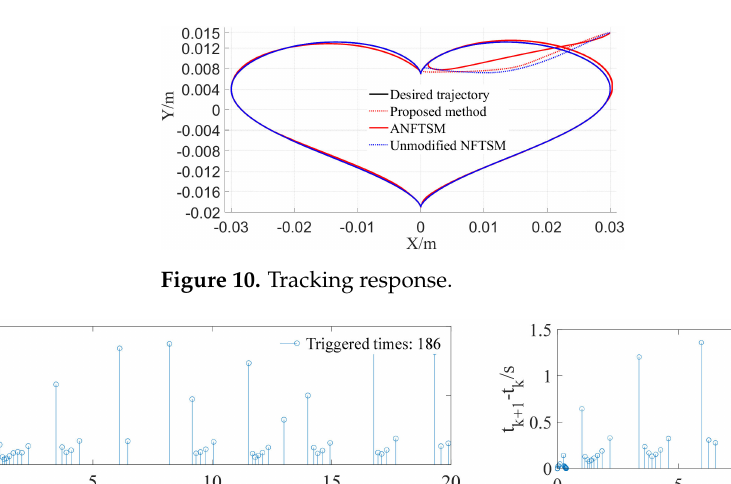
Figure 9. Control inputs. ( A ) X-direction, ( B ) Y-direction.